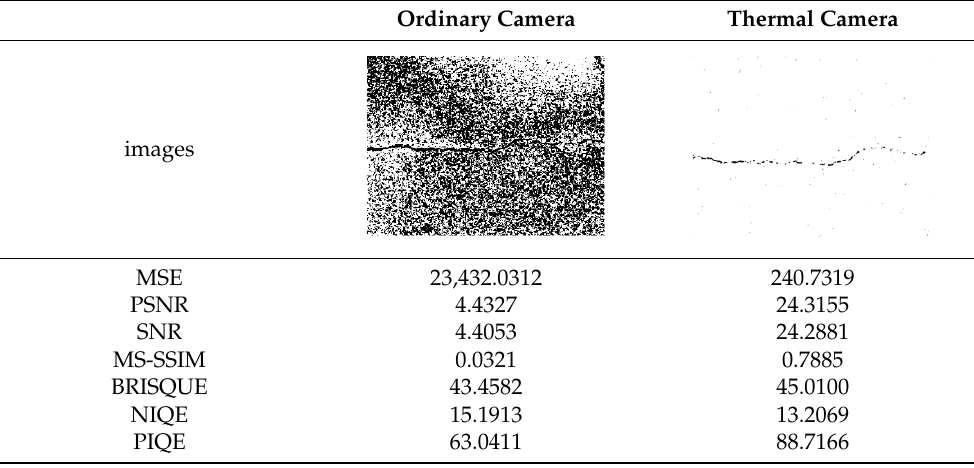
Figure 16. Histogram tonal zone representation of the sample image using a thermal camera.